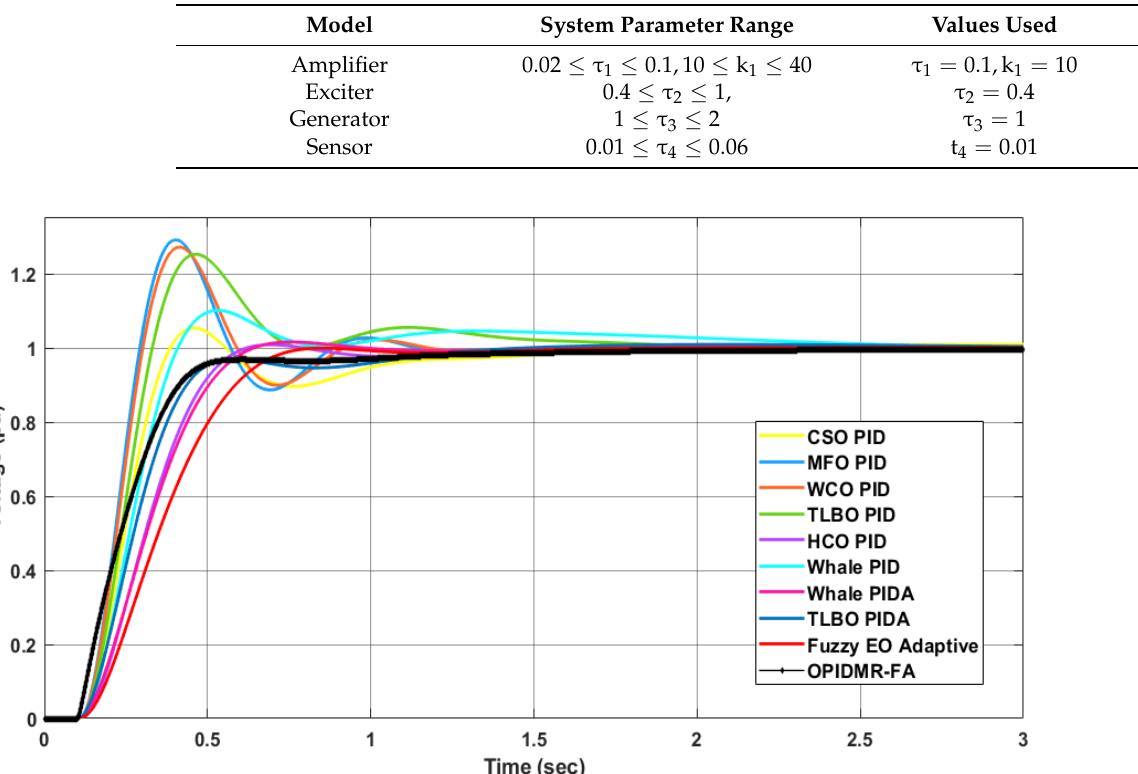
Table 2. Parameters of the AVR system under study.